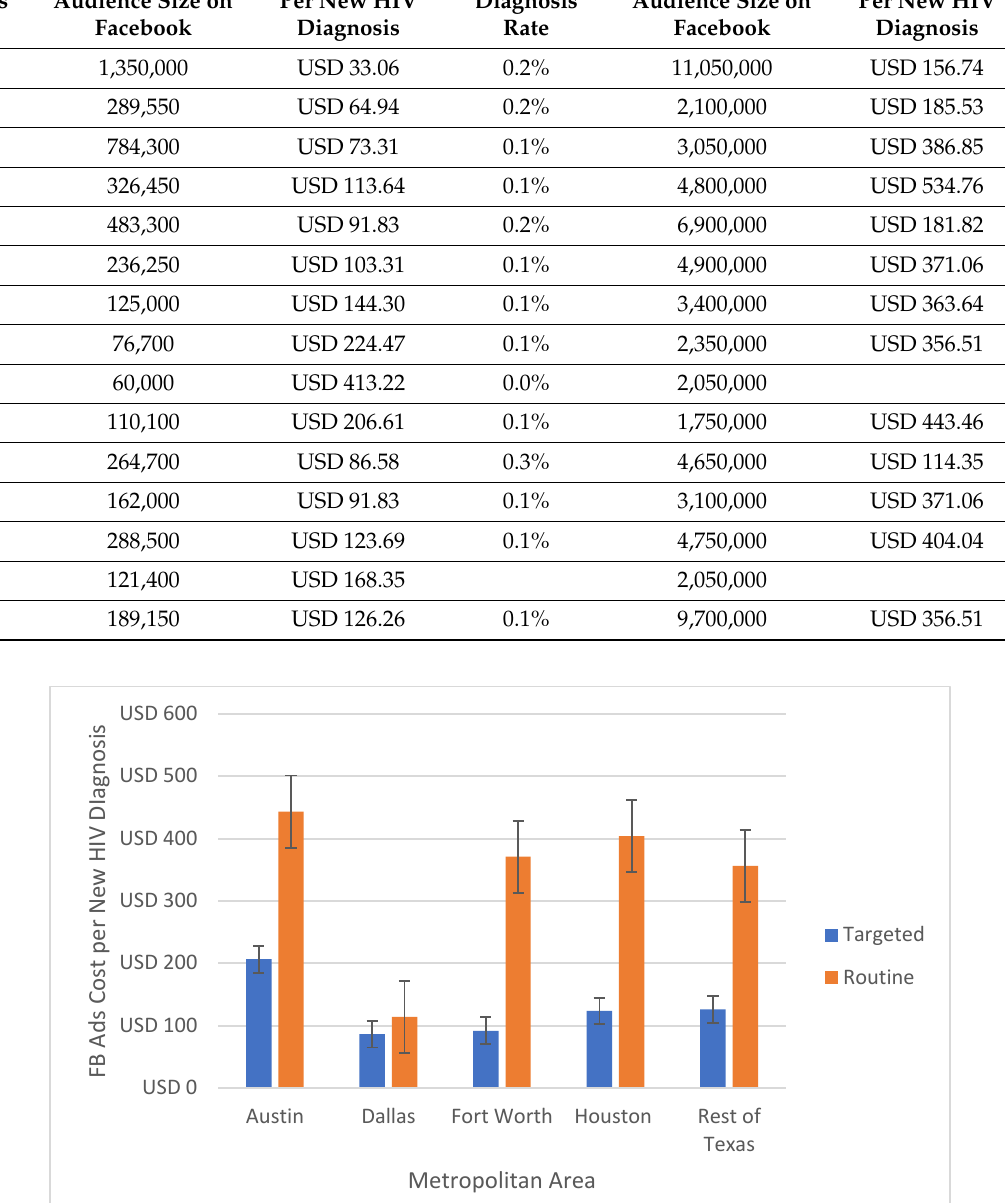
Figure 2. Estimated Ad cost per new HIV diagnosis comparison between targeted and non-targeted models for Texan metropolitan areas in Texas, USA.